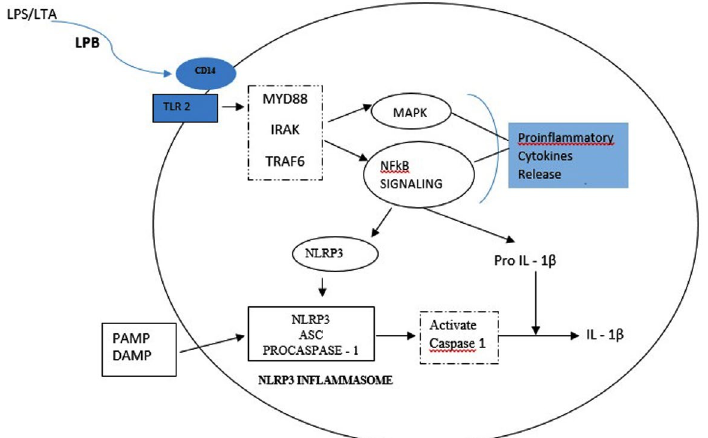
Fig. 1. LTA binds to CD14 receptor and are subsequently presented to Toll – like receptor (TLR). This stimulates the formation of a signalling complex that involves MyD88, IL-1receptor associated kinase (IRAK), and tumour necrosis factor receptor- associated factor 6 (TRAF 6). Signalling of this complex leads to activation of pathways that regulate NFκB nuclear factor - κB; MAP: mitogen – activating protein leading to release of pro inflammatory cytokines. A primary Signalling pathway through NFκB causes expression of NLRP3 and pro-IL-1β. A second signal PAMPs (Pathogen-Associated Molecular Patterns) and DAMPs (Danger-Associated Molecular Pattern) activates NLRP3 inflammasome assembly that leads to activation of caspase-1 and the cleavage and secretion of active IL-1β .